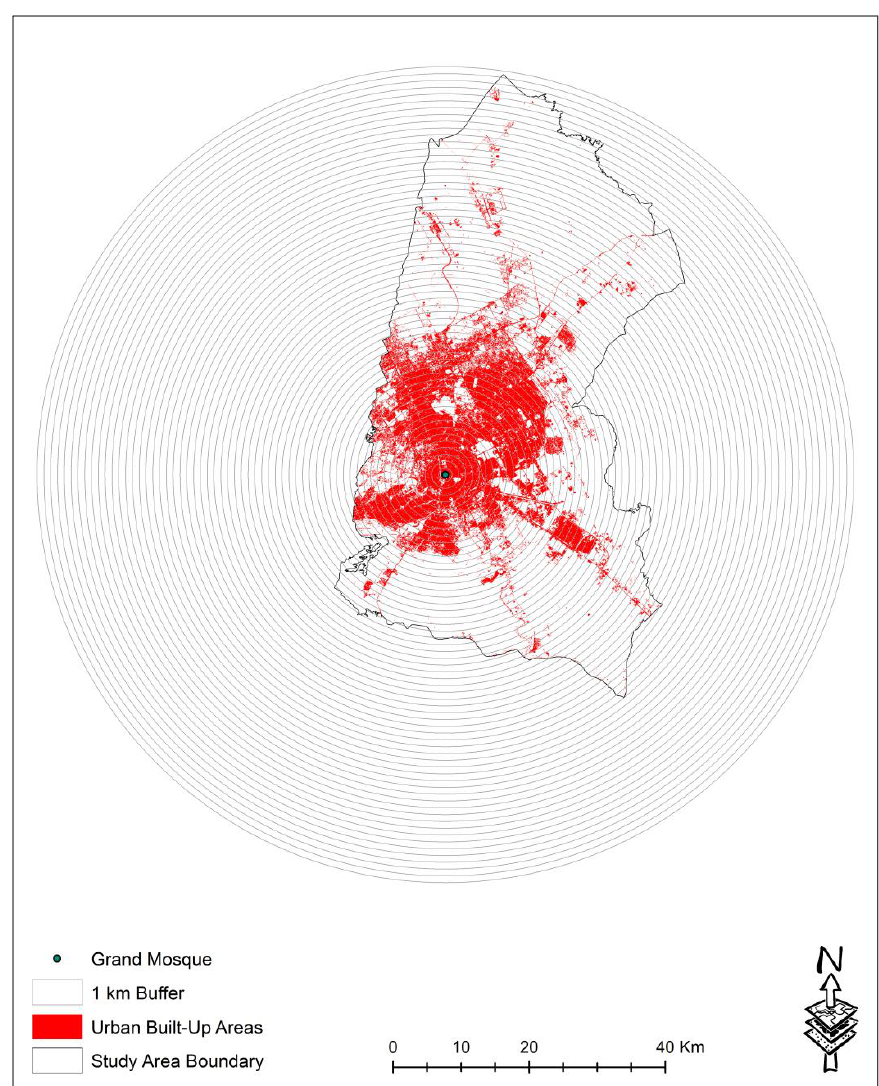
Figure 3. Buffers drawn to calculate Shannon’s Entropy using 2009 LULC classified data.